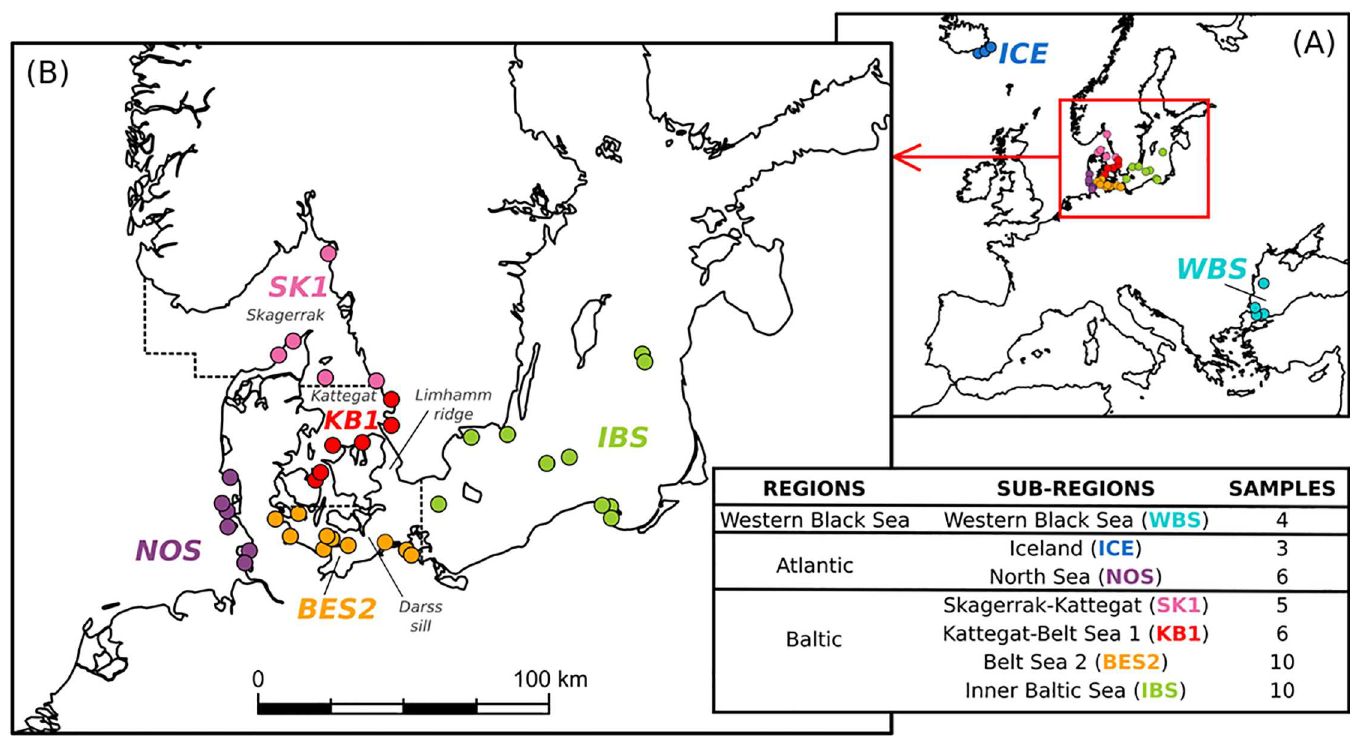
Fig 1. Sampling locations and assignment to geographic sub-regions. (A) A map of EuropeanSeas with circles representing collectionsites for individualsamples from the Western Baltic Sea (WBS), the Atlantic and the Baltic Sea regions. WBS and Icelandicsamples (part of the Atlantic region) are labeledwith light blue and dark blue circles, respectively. (B) Collectionsites for individualsamples from the North Sea sub-region (NOS; purple), and Baltic Sea sub-regions: Skagerrak-northern Kattegat (SK1; pink), southern Kattegat-Belt Sea 1 (KB1; red), Belt Sea 2 (BES2; orange), Inner Baltic Sea (IBS; green). Borders between SK1 and KB1, and BES2 and IBS (dashed lines) were based on proposedborders between management units at 56.95˚N latitude, and 13.5˚E longitude, respectively(39). Borders between NOS and SK1, and KB1 and BES2 are based on [32]. Geographic assignment to regions and sub- regions is summarized in a table (bottom right). Map data: ESRI